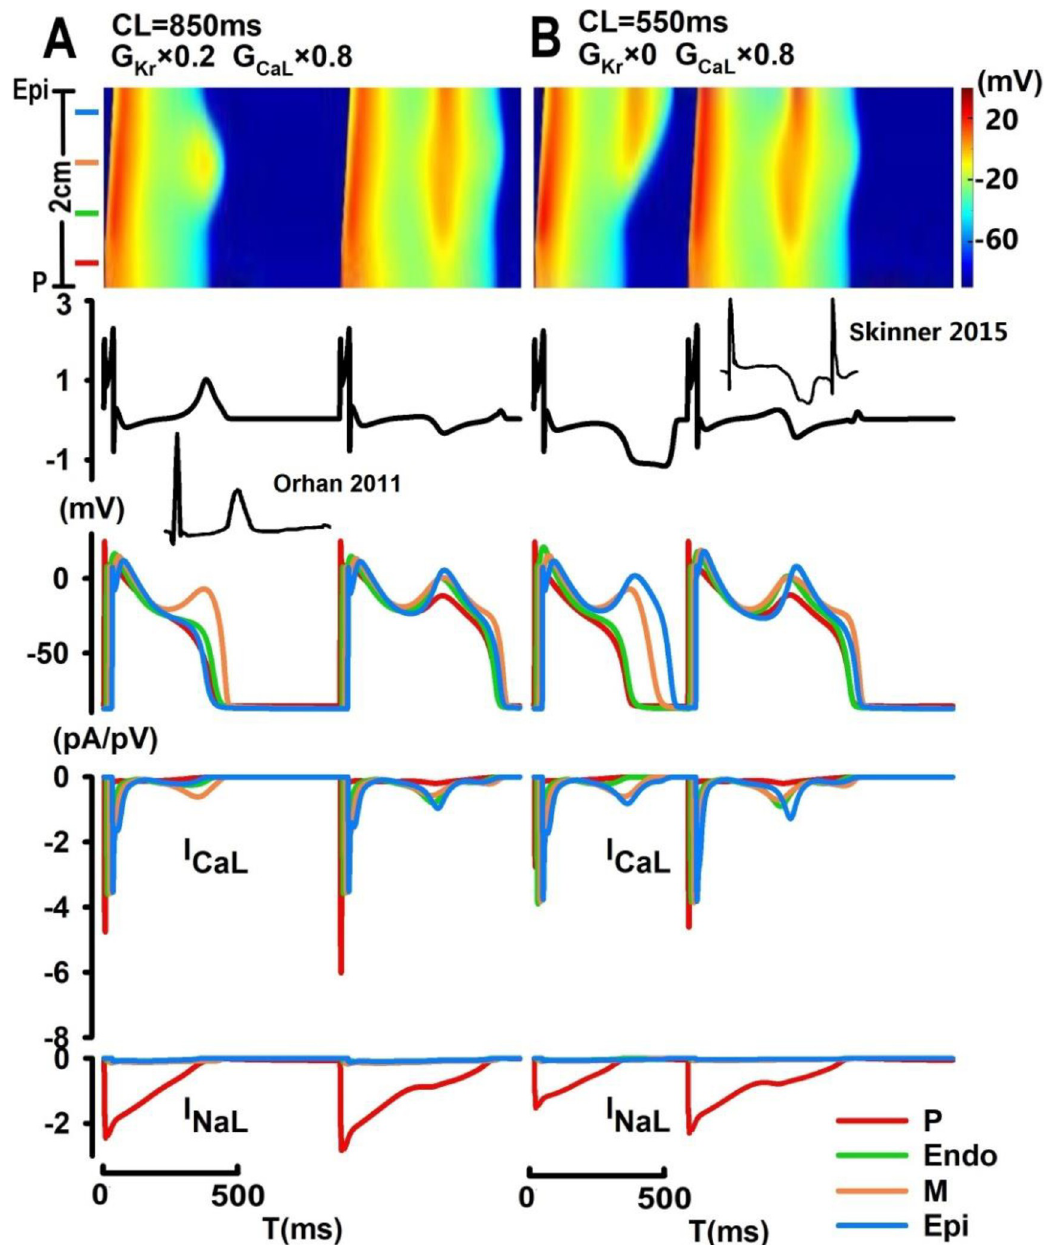
Fig 5. Computer simulation of localized EAD events. (A) With an 80% reduction in I Kr and a 20% reduction in I CaL , localized EAD can arise exclusively from the midmyocardium at CL = 850 ms, with a late-appearing and pointed T-wave; (B) with complete inhibition of I Kr and a 20% reduction in I CaL , localized EAD can arise simultaneously in the mid- and epicardium, with an inverted broad-based T-wave. (QT = 503.6 ms; T = 162.9 ms). In Fig 6(B) and 6(C), with 60% reduction of I pe EAD in the midmyocardium (beat #2) can trigger retrograde excitation in the PVS at CL = 650 ms with a conduction velocity (CV) of 0.2 m/s, and sequential development of EAD upstrokes from M cells to Endo and P cells (Fig 6B) with a broad-based asymmetric T-wave (QT = 488.3 ms; T = 172.4 ms); at a slower pacing rate (CL = 850 ms), a much slower spontaneous retrograde pe